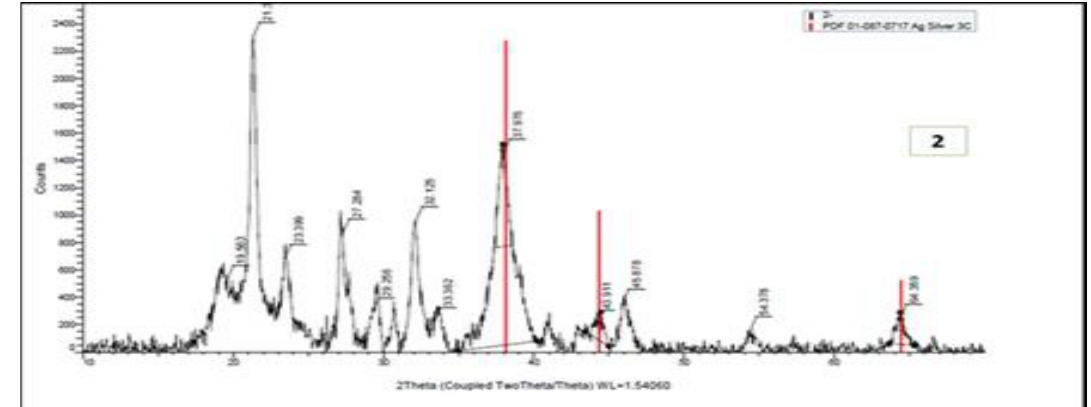
Figure 10. FTIR of silver nanoparticles formed by Acinetobacter baumannii